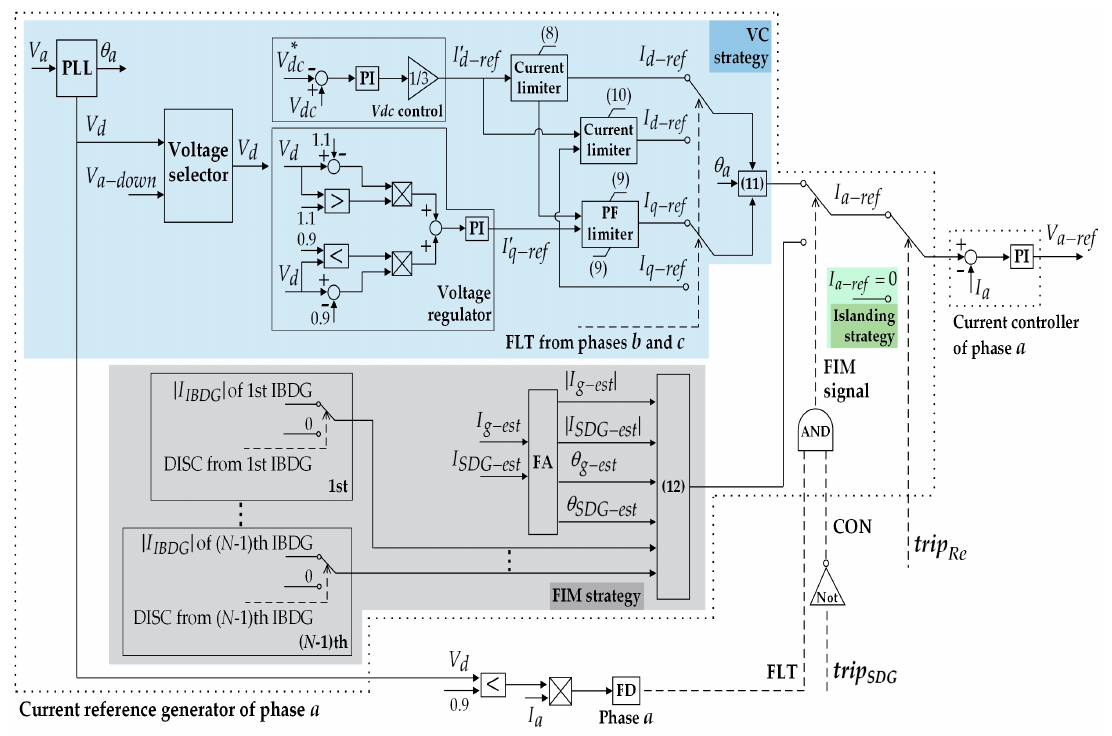
Figure 3. Control diagram of the separated phase–current control for phase a (References [19], [20], and [26]).